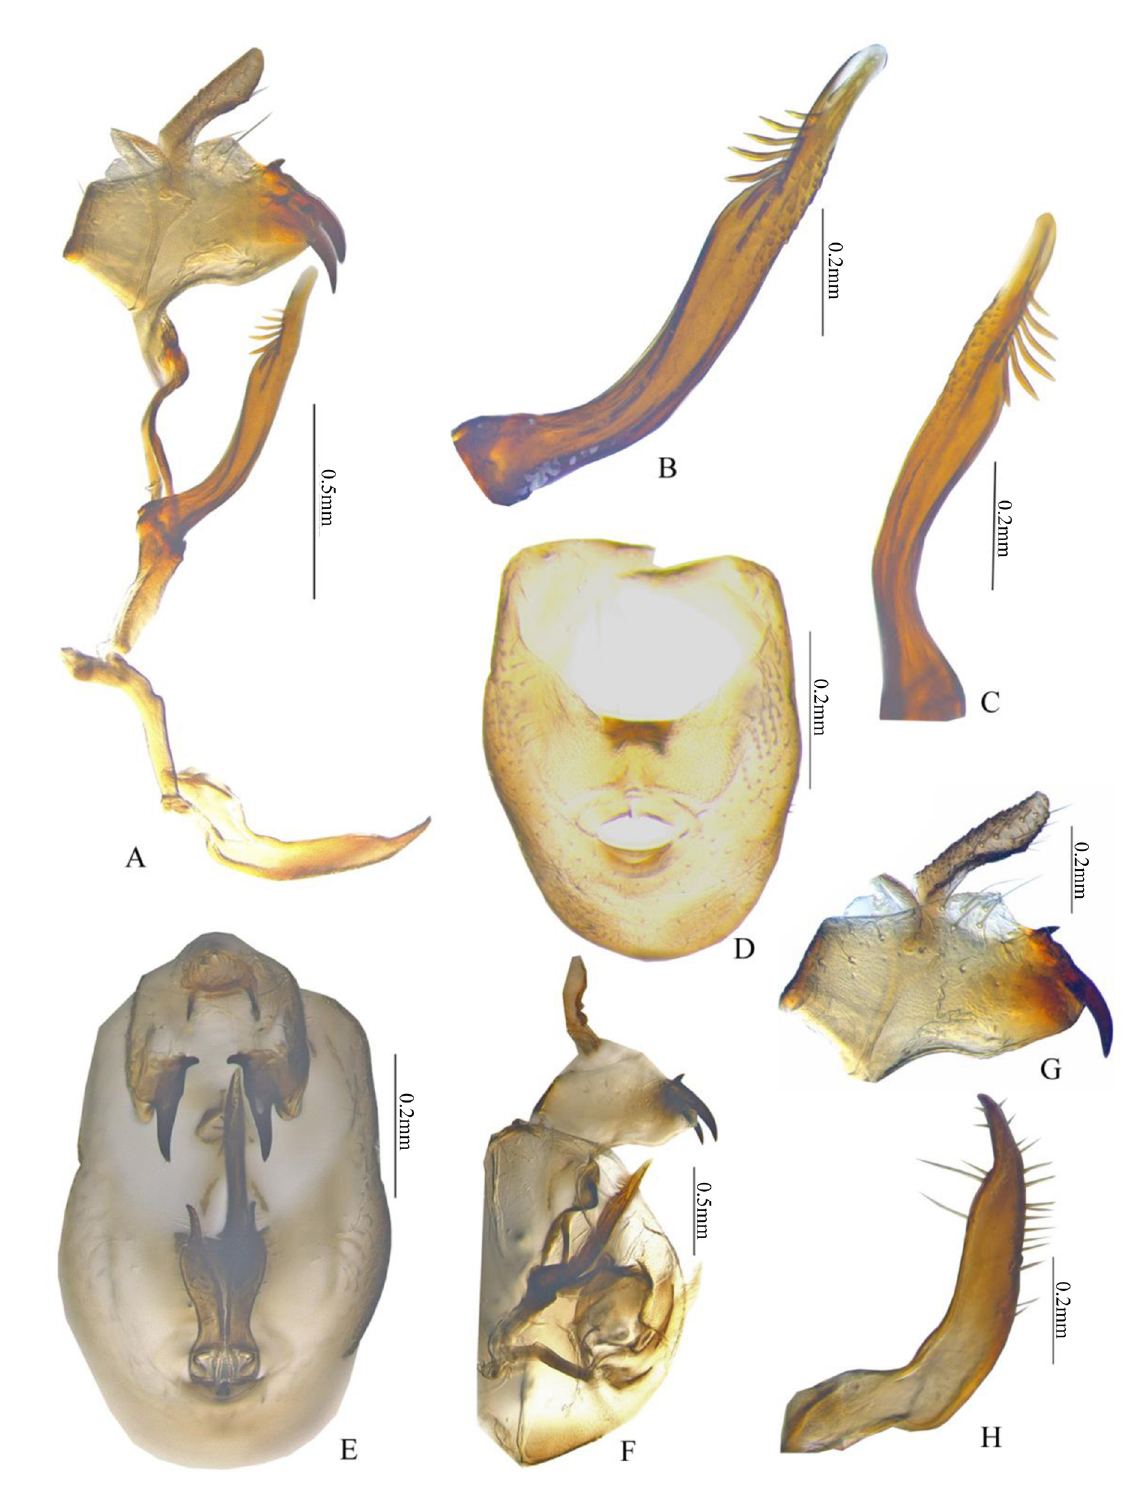
Fig. 2. Parasogata sexpartita sp. nov., male genitalia, holotype (NPC HEMT7). A . Aedeagal complex. B . Aedeagus, left view. C . Aedeagus, right view. D . Pygofer, caudal view. E . Male genitalia, caudal view. F . Male genitalia, lateral view. G . Segments 10 and 11. H . Paramere, lateral